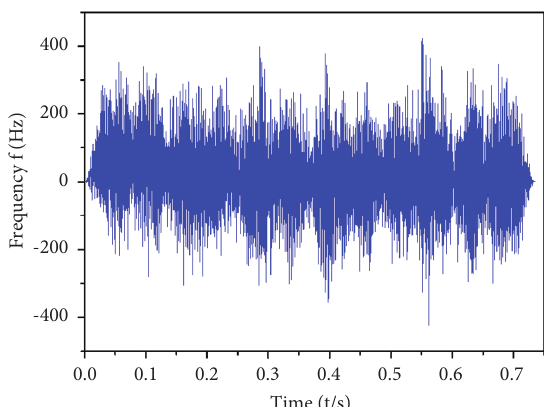
Figure 11: The time domain waveform of the train bearing.